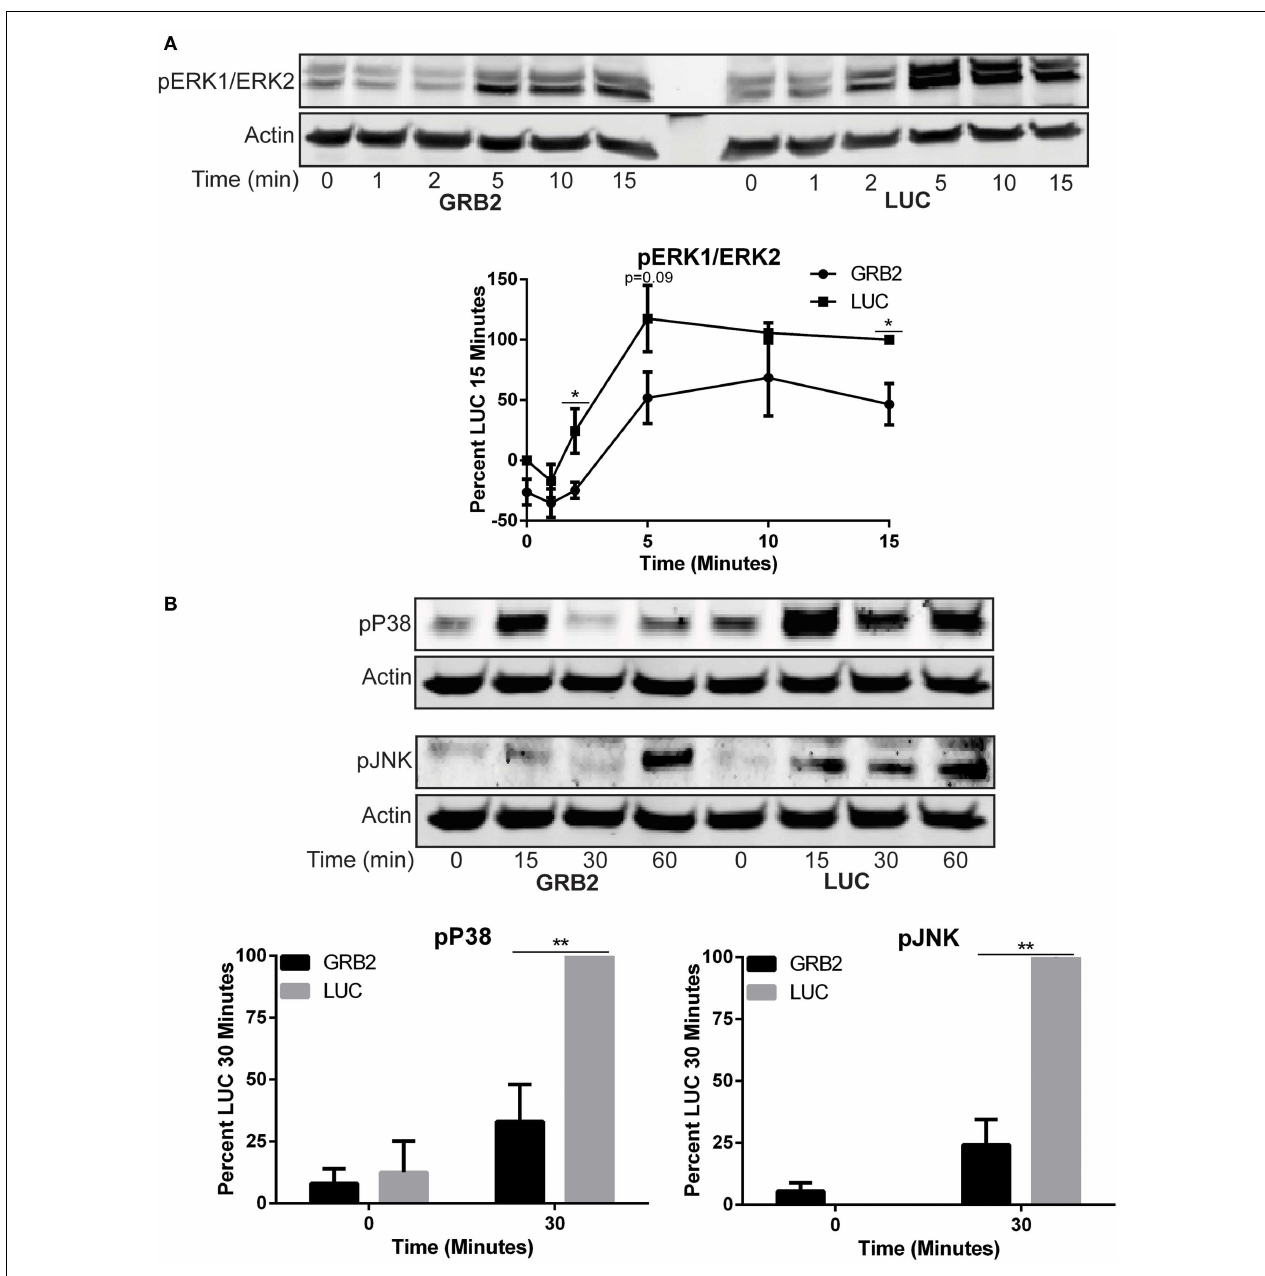
FIGURE 4 |Activity of MAP kinases, ERK1/ERK2, p38, and JNK is reduced in the absence of GRB2 .The phosphorylation of proteins in GRB2 deficient or control HuT78T cells stimulated with 2 µ g/mL soluble anti-CD3 was detected by immunoblotting using antibodies